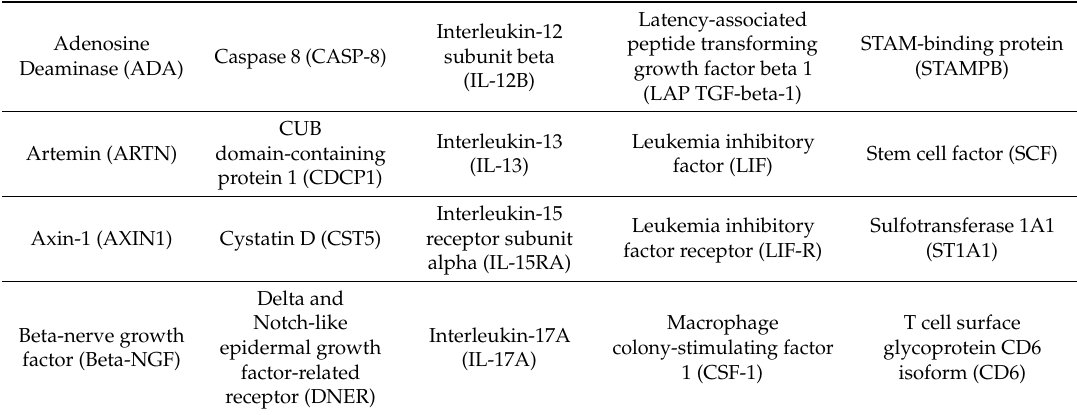
Table 3. 92 inflammatory markers contained within the Proseek Multiplex inflammation assay (Olink Bioscience, Uppsala,